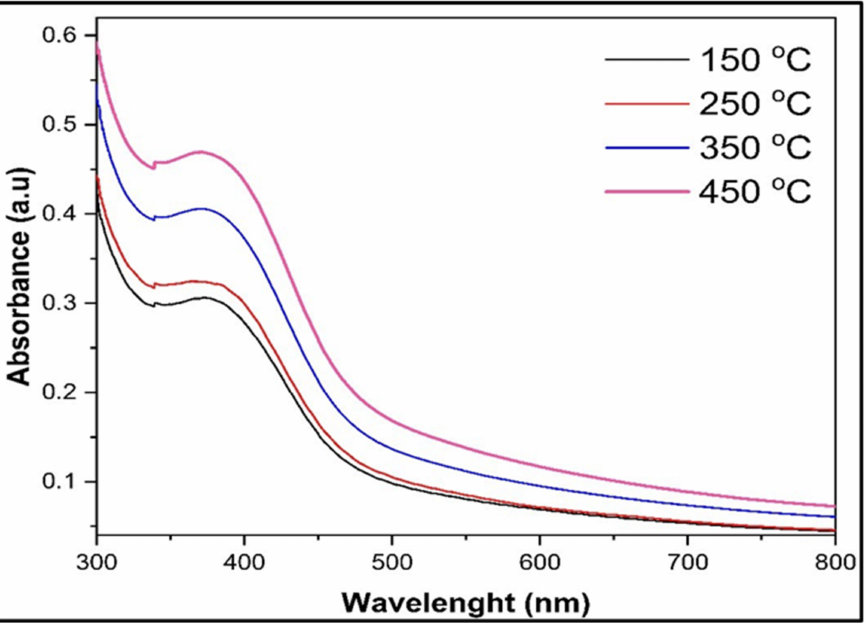
Figure 8. The UV–visible spectra of ZnO nanoparticles synthesized using a green method and the leaf extract of the thyme plant at different calcination